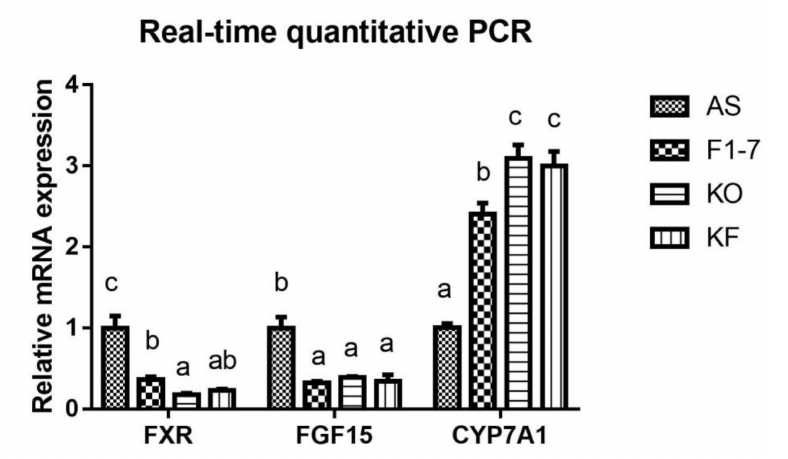
Figure 5. Relative mRNA levels of intestine FXR, FGF15, and liver CYP7A1 genes involved in lipid metabolism (n = 4). Different letters indicate significant differences from each group, p <